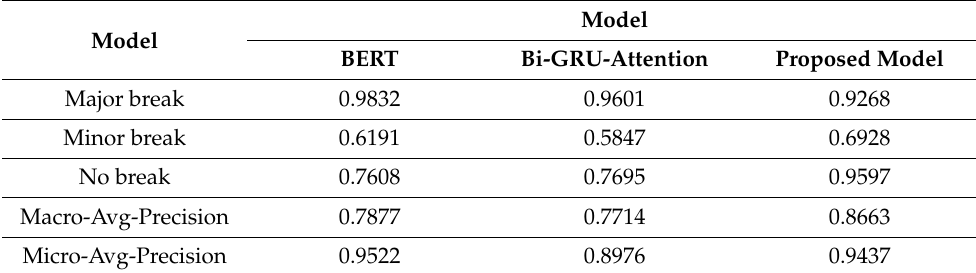
Table 12. Overall performance comparison with previous work.